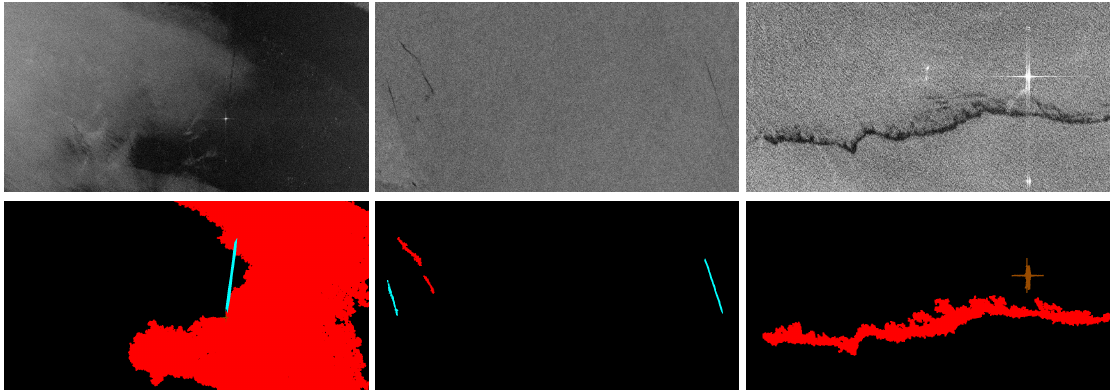
Figure 3. Sample SAR images ( left ) and corresponding ground truth masks ( right ) of oil spill dataset considered as worst-case